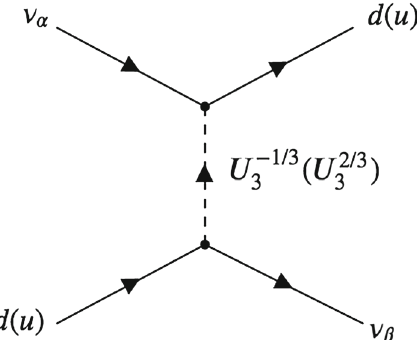
Fig. 1 Feynman diagram for the interaction of neutrinos with u and d quarks through the exchange of U 3 vector